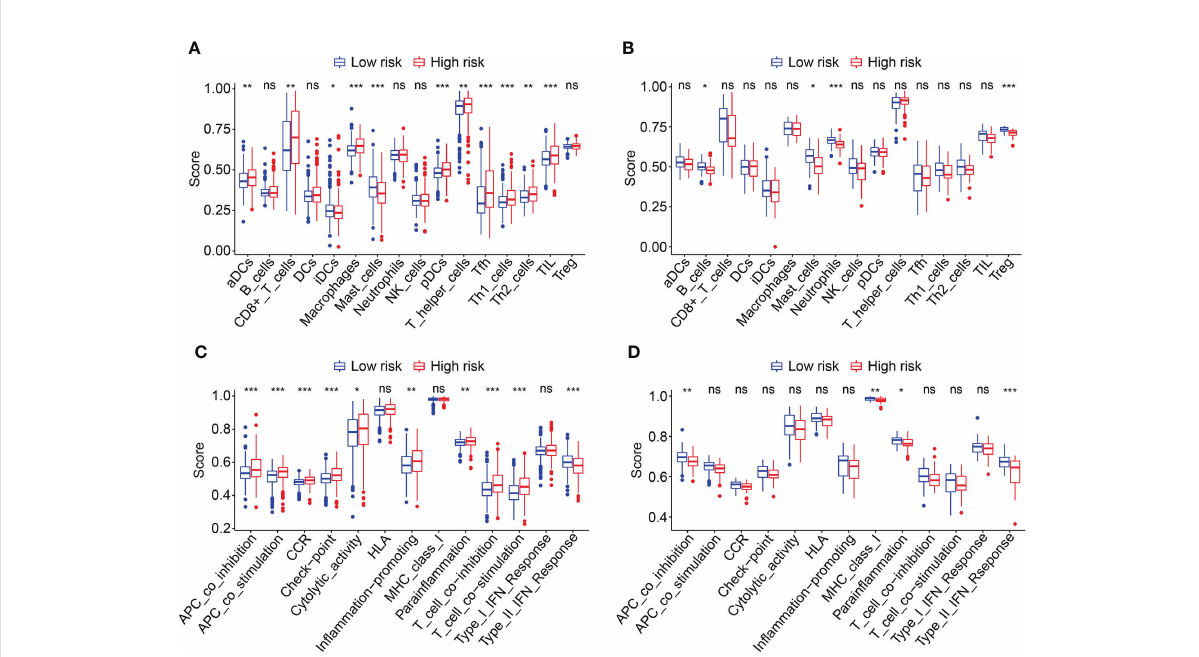
FIGURE 9 Comparison of immune cell in fi ltration and immune function based on ssGSEA. (A, B) Box plots exhibiting enrichment scores of immunocytes between the two subgroups in TCGA and ICGC cohorts. (C, D) Box plots exhibiting enrichment scores of the related-immune function between the two subgroups in TCGA and ICGC cohorts * P < 0.05; ** P < 0.01; *** P < 0.001. not signi fi